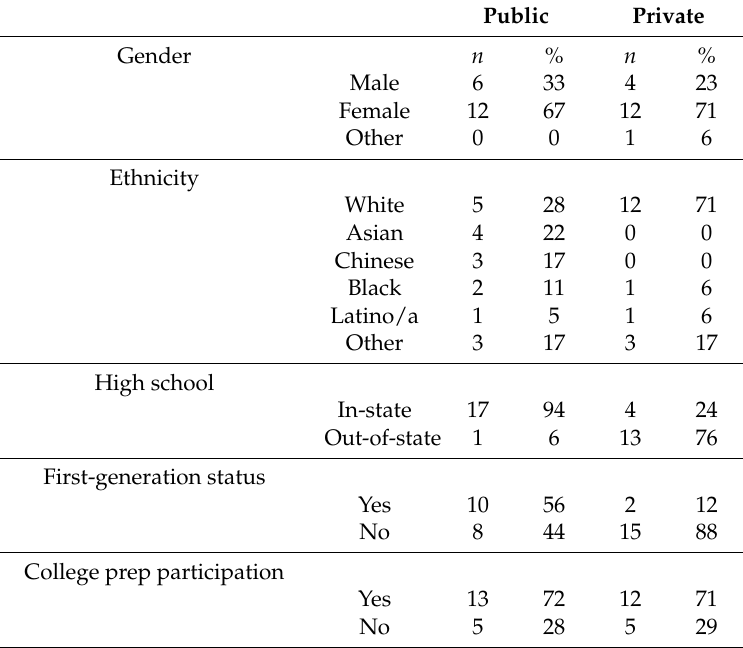
Table 2. Participant demographics by